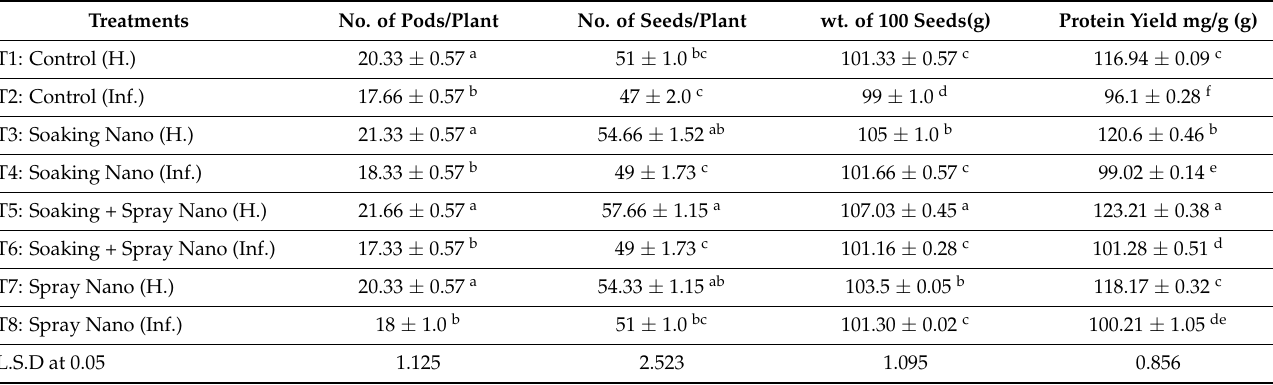
Table 4. Effect of Se-NPs on the yield of ( Vicia faba L.)